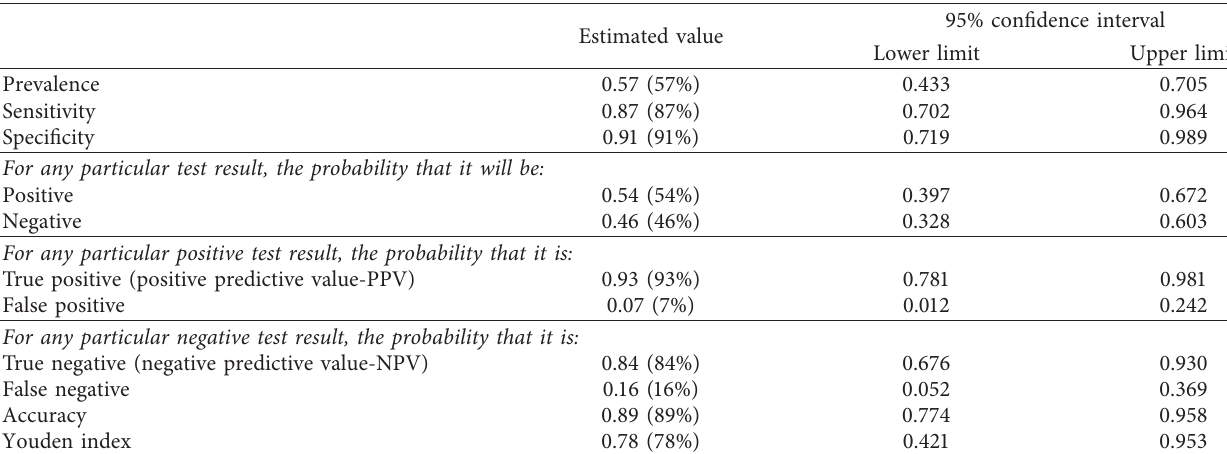
Table 5: Results of sensitivity, specificity, positive predictive value, negative predictive value, accuracy, and Youden index for the cold test with confidence intervals 95% (CI 95%) and at 57% prevalence of IANB failure.